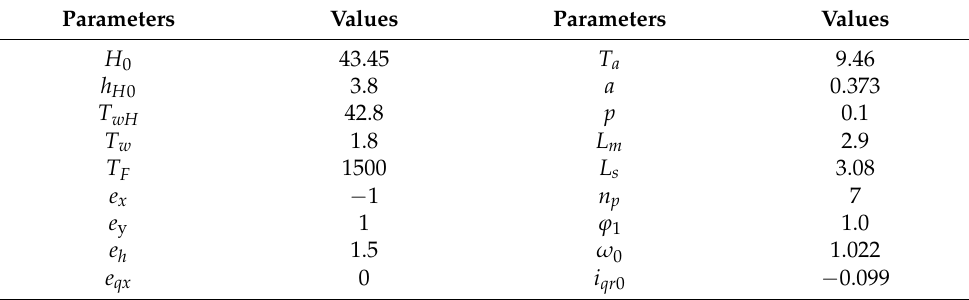
Table 1. Parameters of the